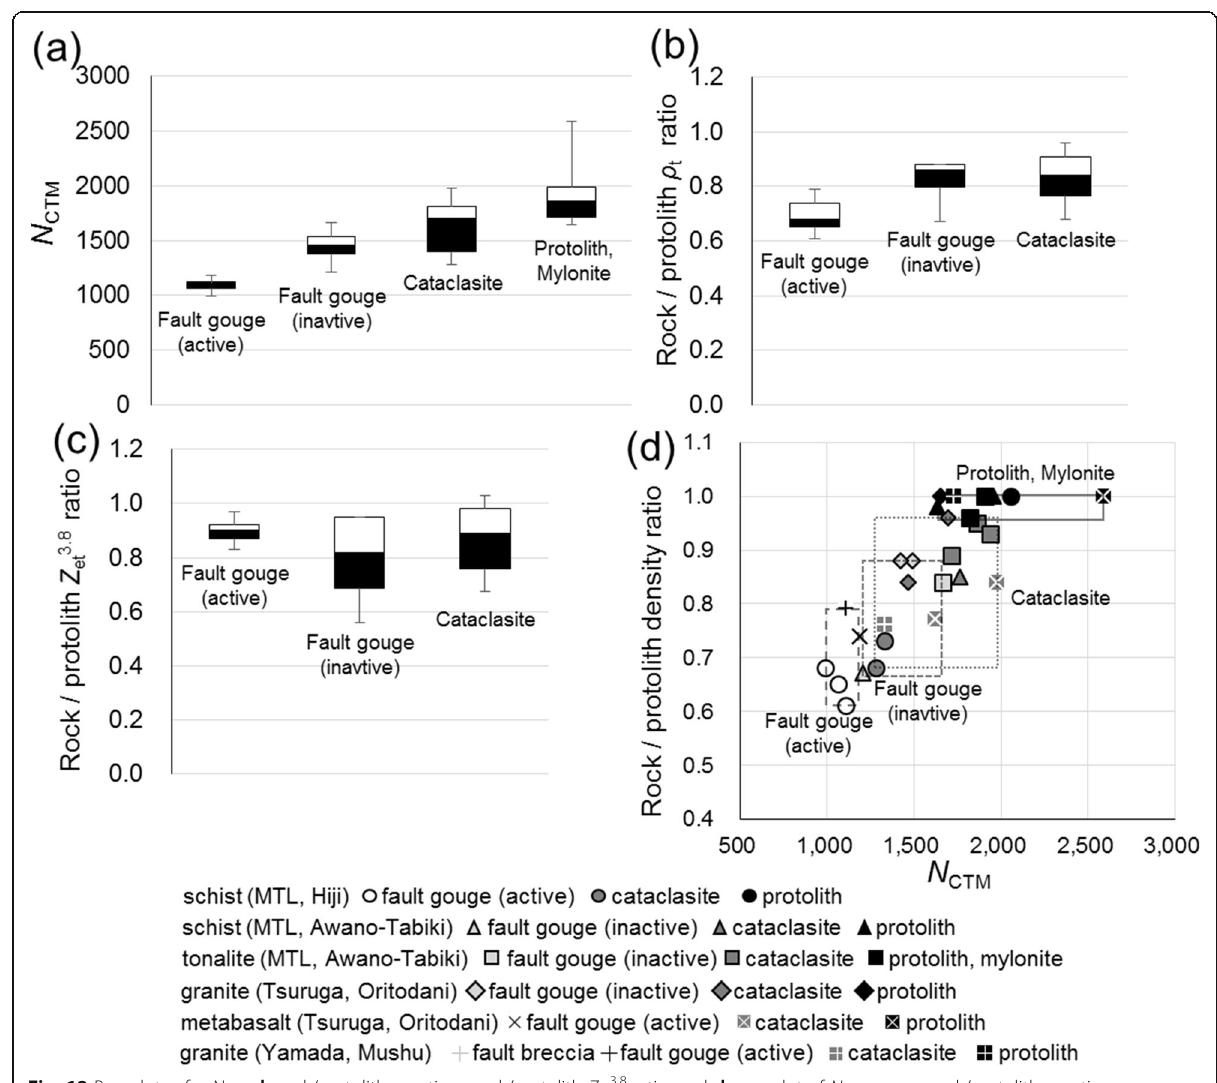
Fig. 12 Box plots of a N CTM , b rock/protolith ρ t ratio, c rock/protolith Z et3.8 ratio, and d crossplot of N CTM versus rock/protolith ρ t